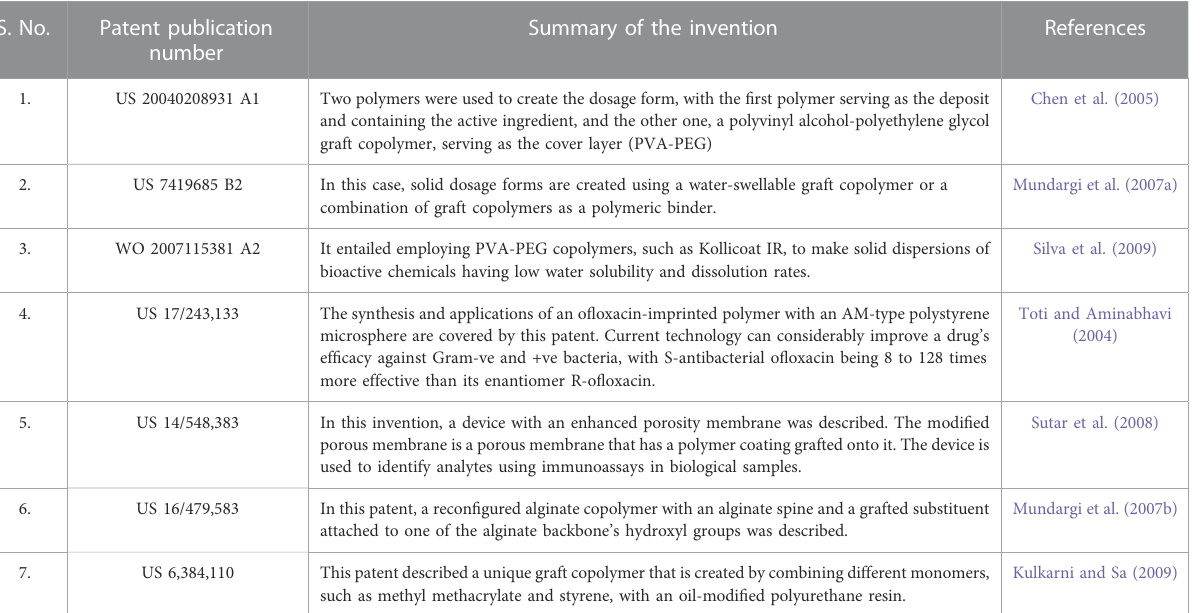
TABLE 3 Patents involving polymer